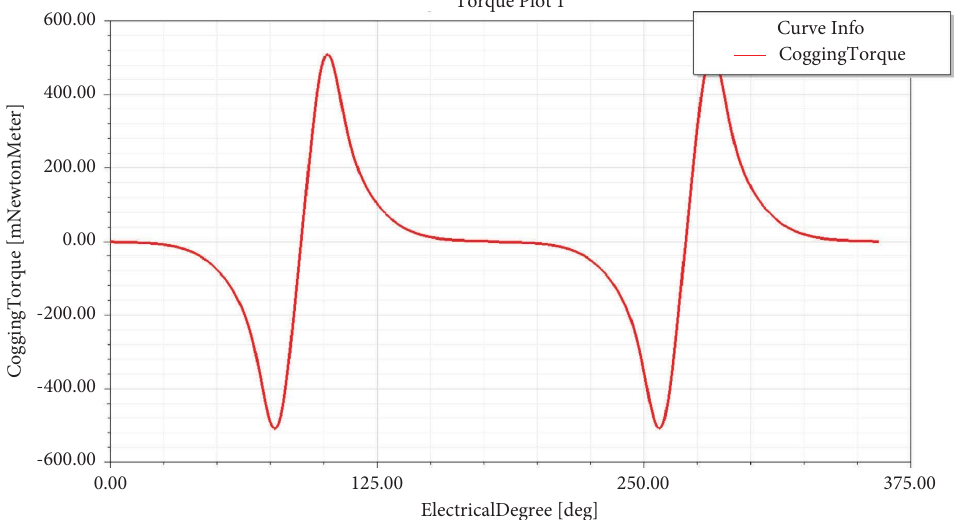
Figure 2: Torque curve of 4-pole 12-slot motor.